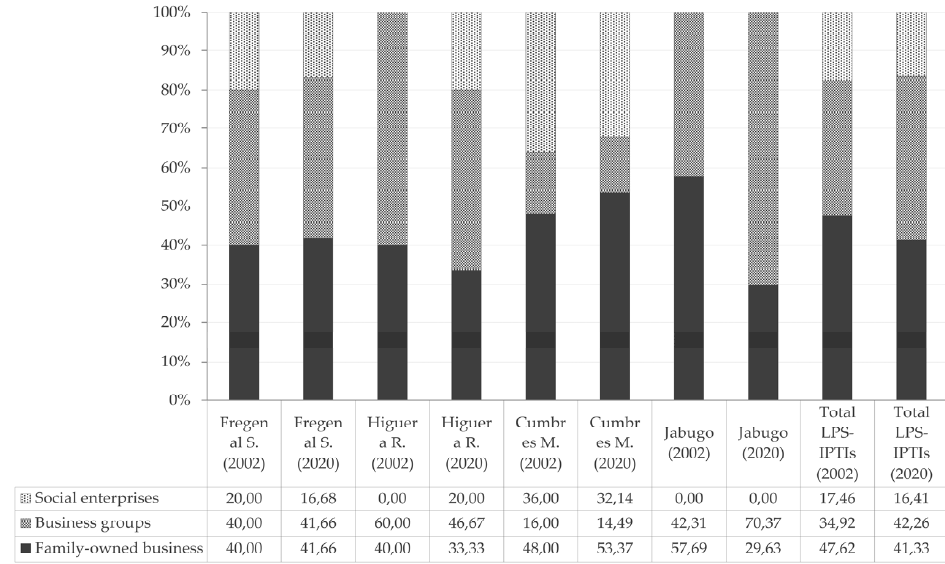
Fregenal de la Sierra, and non-existent in Jabugo.